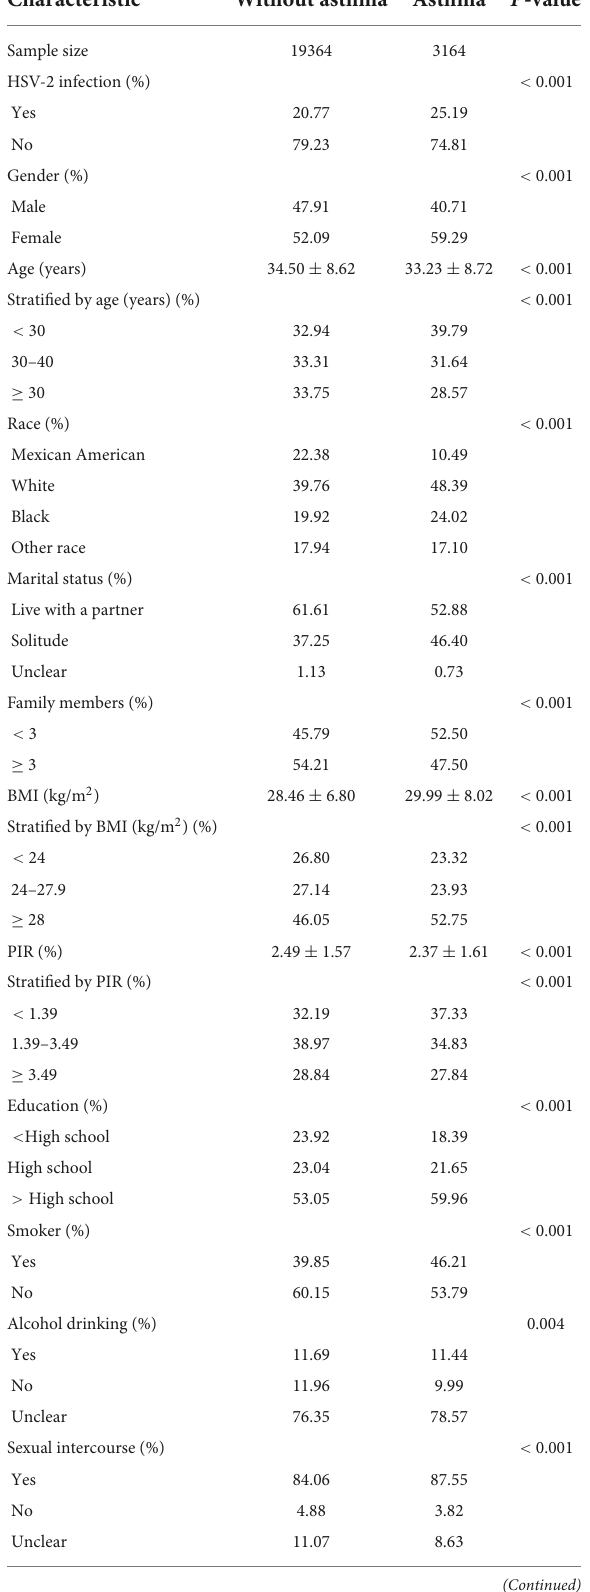
TABLE 1 Baseline characteristics of included